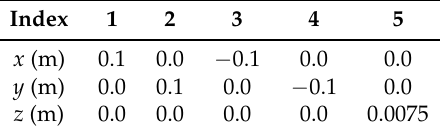
Table 1. The positions of the five electrodes in the UCA system.